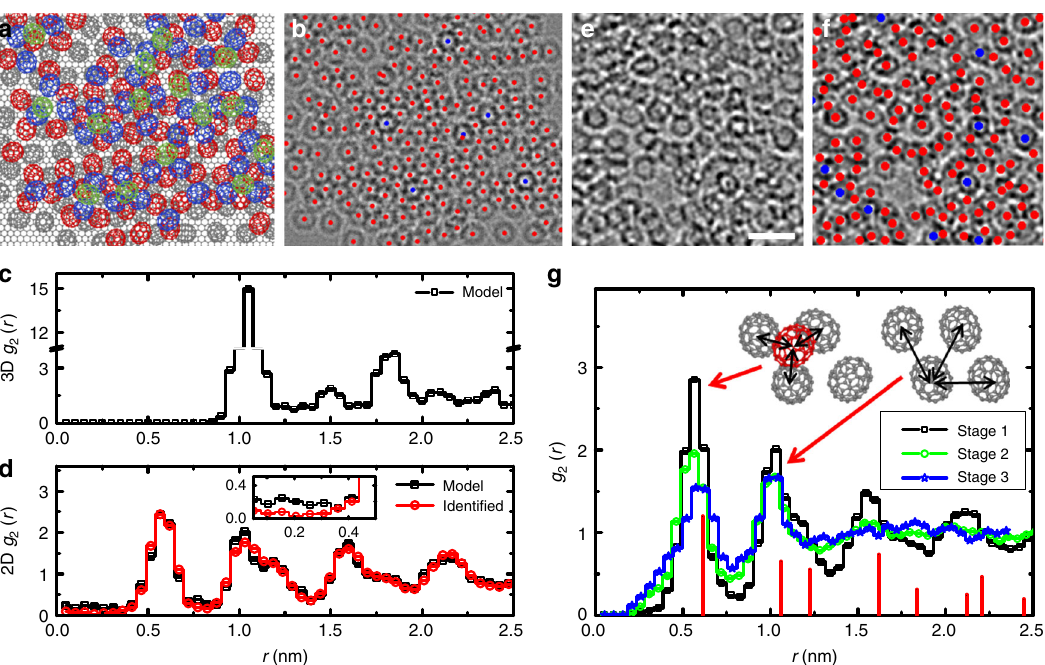
Fig. 3 Identi fi cation of C 70 positions in the disordered molecular structure. a Atomic model of disordered C 70 structure on graphene. b Corresponding TEM simulation image of the model with identi fi ed center position overlay (red dots). Blue dots are doubly-counted positions. c 3D pair correlation function (PCF) from the disordered C 70 molecular model. d 2D-projected PCF from the molecular model and identi fi ed positions. The inset shows the PCF at 0 ≤ r ≤ 0.5 nm. e Experimental TEM image of molecular liquid. Scale bar, 2 nm. f TEM image with identi fi ed center position overlay. g PCF of molecules from experimental data at different stages of melting. The red reference peaks indicate the calculated pair distances with ABC molecular stacking of C 70 crystals. The inset schematics show the atomic models from ABC